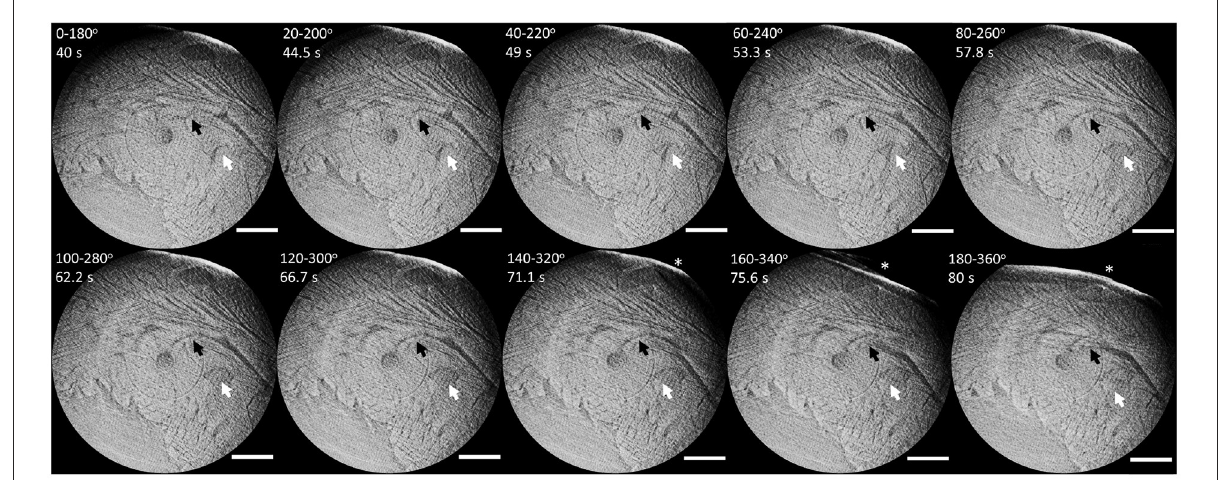
FIGURE5 Series of representative window-reconstructed slices from 0–180 o to 180–360 o in 20 o steps. Black and white arrows indicate example structures progressively changing over time, thus indicating function and/or tissue degradation. The star marks a large variation on the heart surface, probably due to sliding perfusate. Scale bar is 1